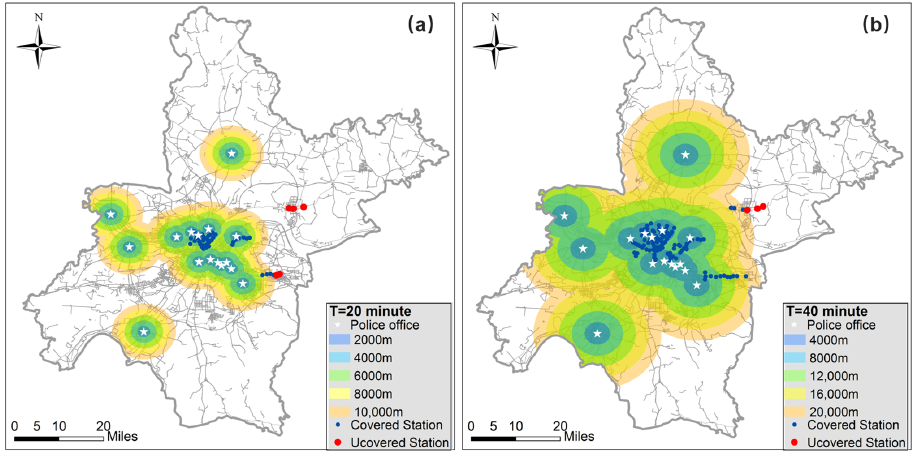
Figure 18. Emergency response zone at T = 20 min ( a ) and T = 40 min ( b ).